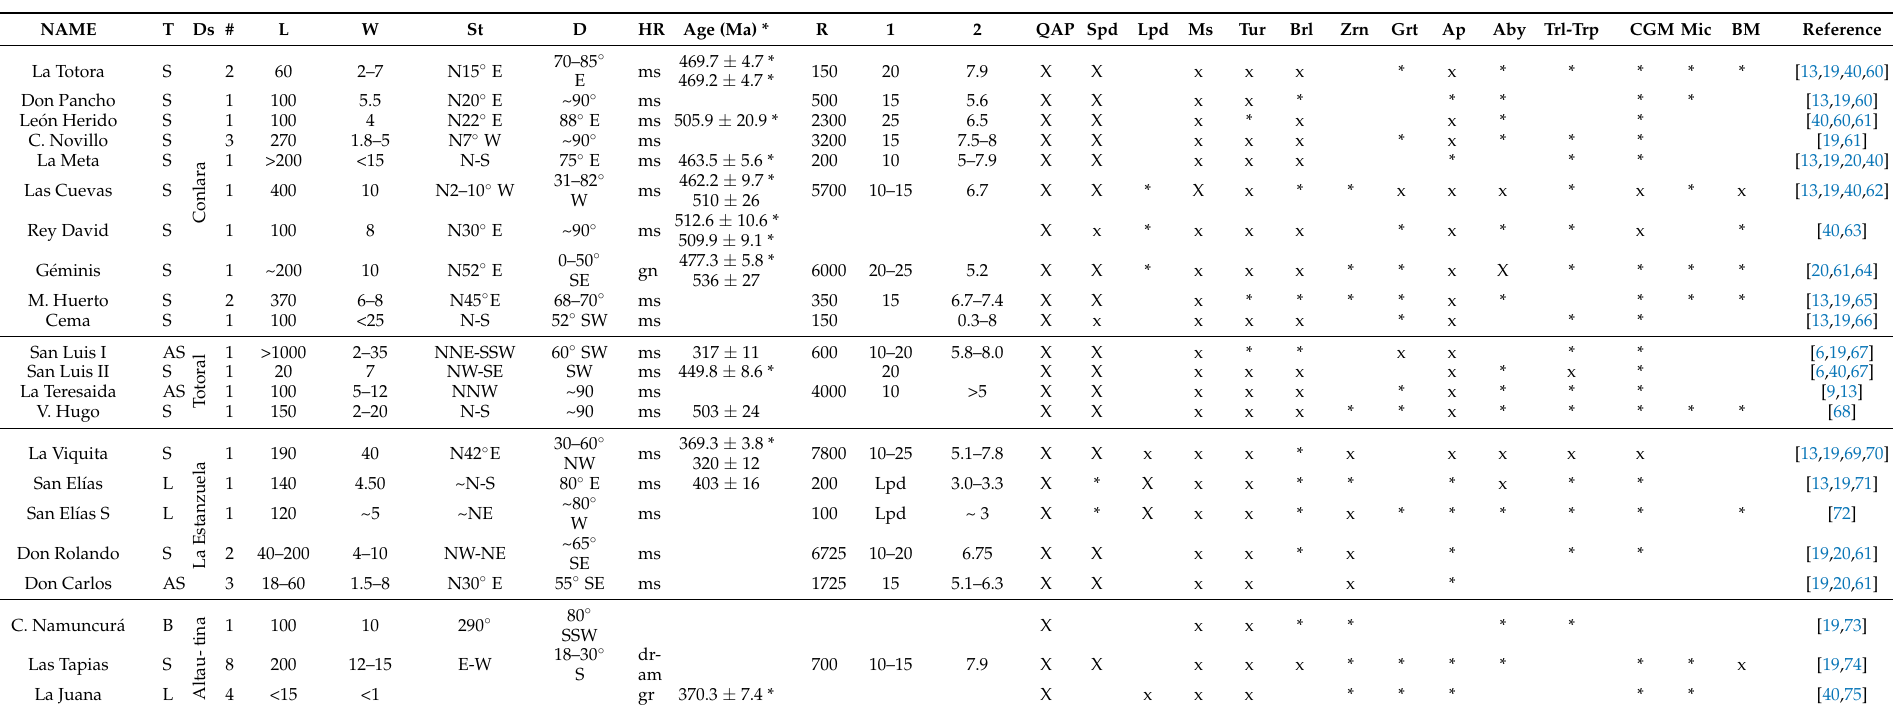
Table 2. Main parameters and mineralogy of lithium pegmatites from the Conlara, Totoral, La Estanzuela, and Altautina